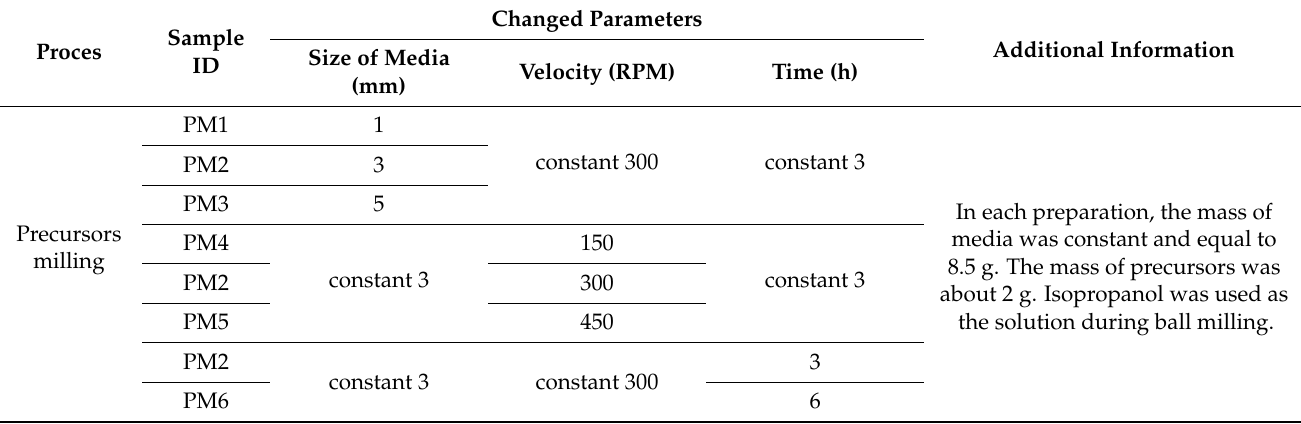
Table 1. List of samples with particular synthesis parameters values used in this